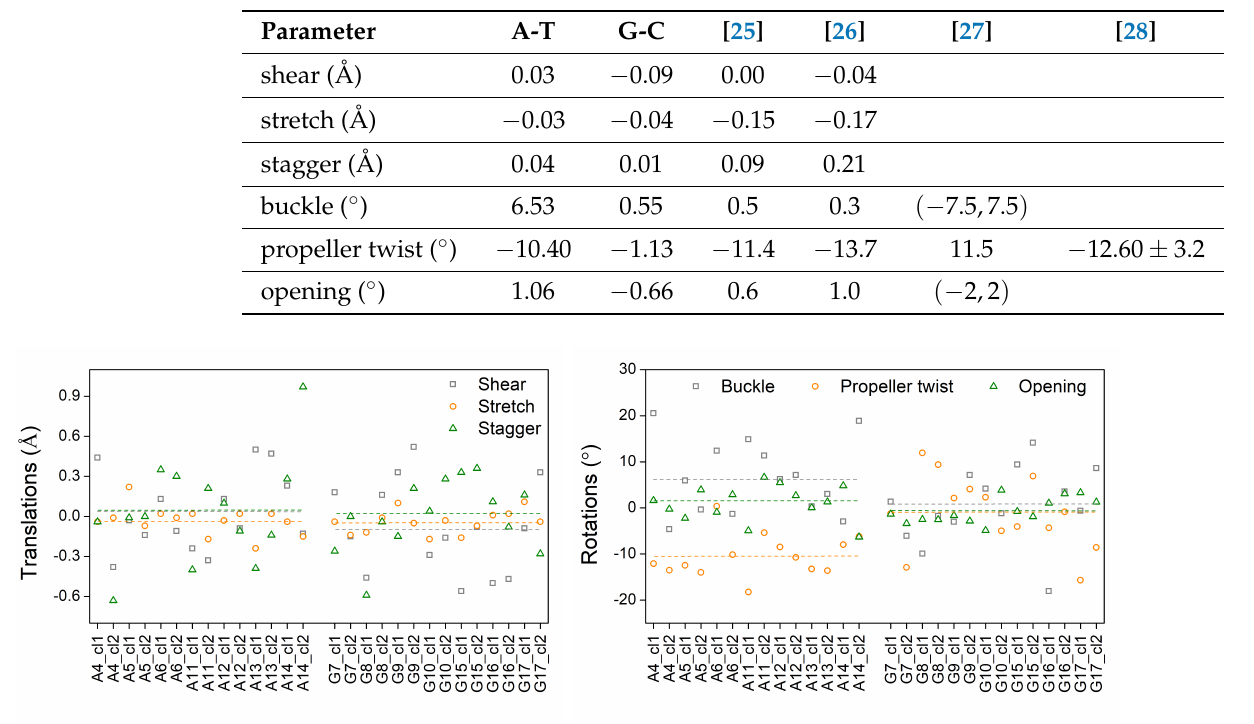
Table 3. The second and third column contain mean values of translation and rotation parameters for monomers A-T and G-C, as studied in the present work. Other columns list values from bibliography.